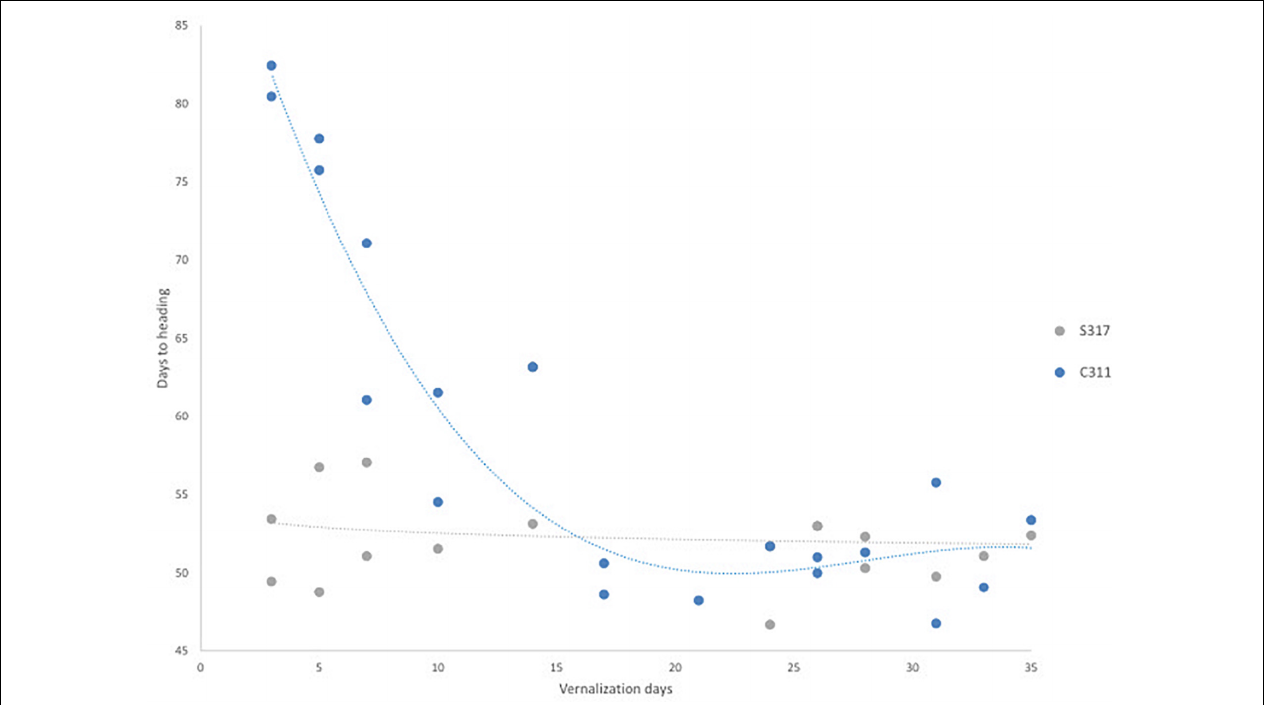
FIGURE 2 | The effect of vernalization on flowering time for S317 and C311. Germinated seeds were exposed to increasing longer durations of a vernalization (4 ◦ C) treatment. In C311, there is a steep decrease in the time to flowering as the length of vernalization increases and the relationship between duration of vernalization and days to heading was significant. This slope levels out at approximately 17 days and does not decrease the time to flowering after further exposure to vernalization